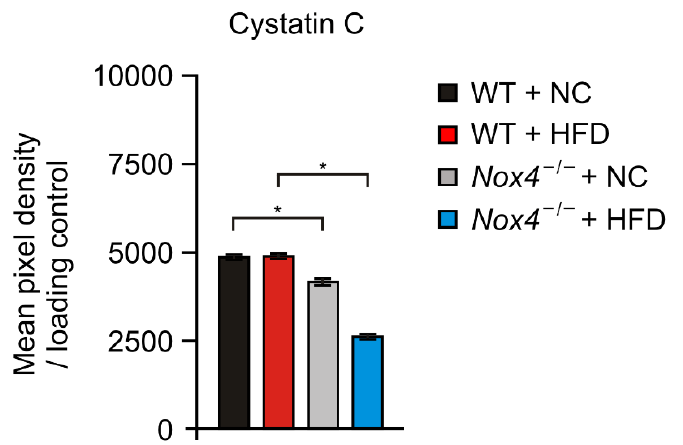
Figure 4. NOX4 deficiency suppresses the production of Cystatin C in the hippocampus during chronic HFD. Quantification of Cystatin C (left) secretion in the hippocampus from Nox4 − / − and WT mice with HFD or NC diet. Data are mean ± standard deviation (SD). *, p < 0.05 by Student’s two-tailed t -test.